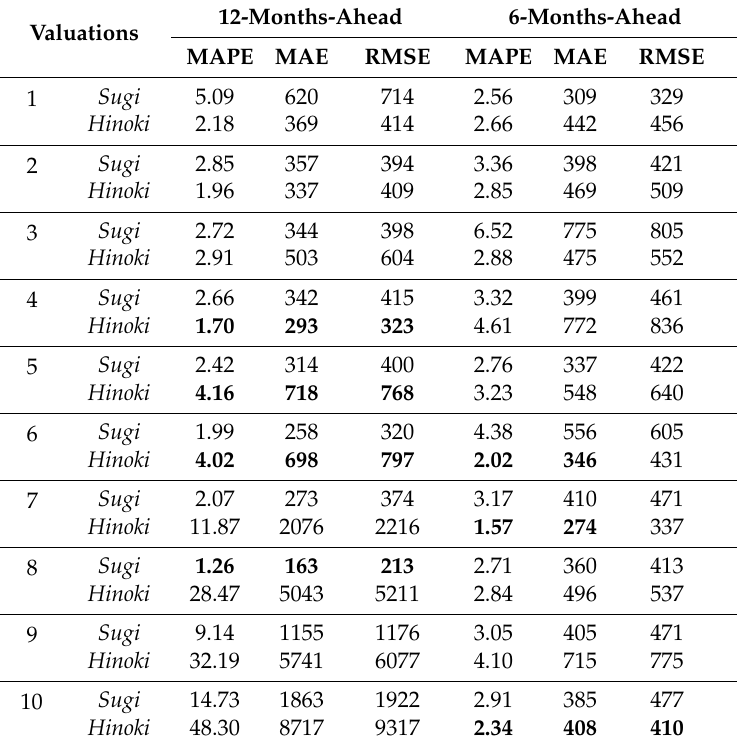
Table 4. Forecast errors using average method for 12- and 6-months ahead forecasts.